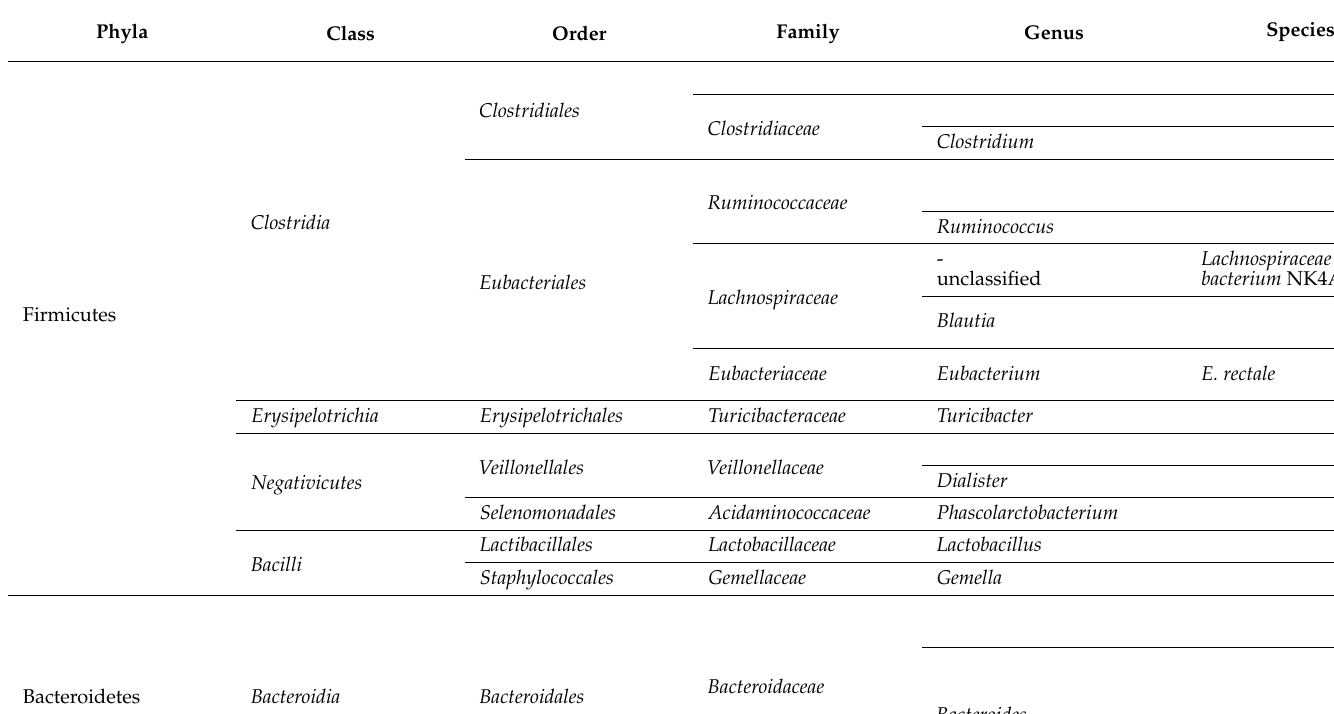
Table 2. Changes in gut microbiota composition in various forms of cognitive